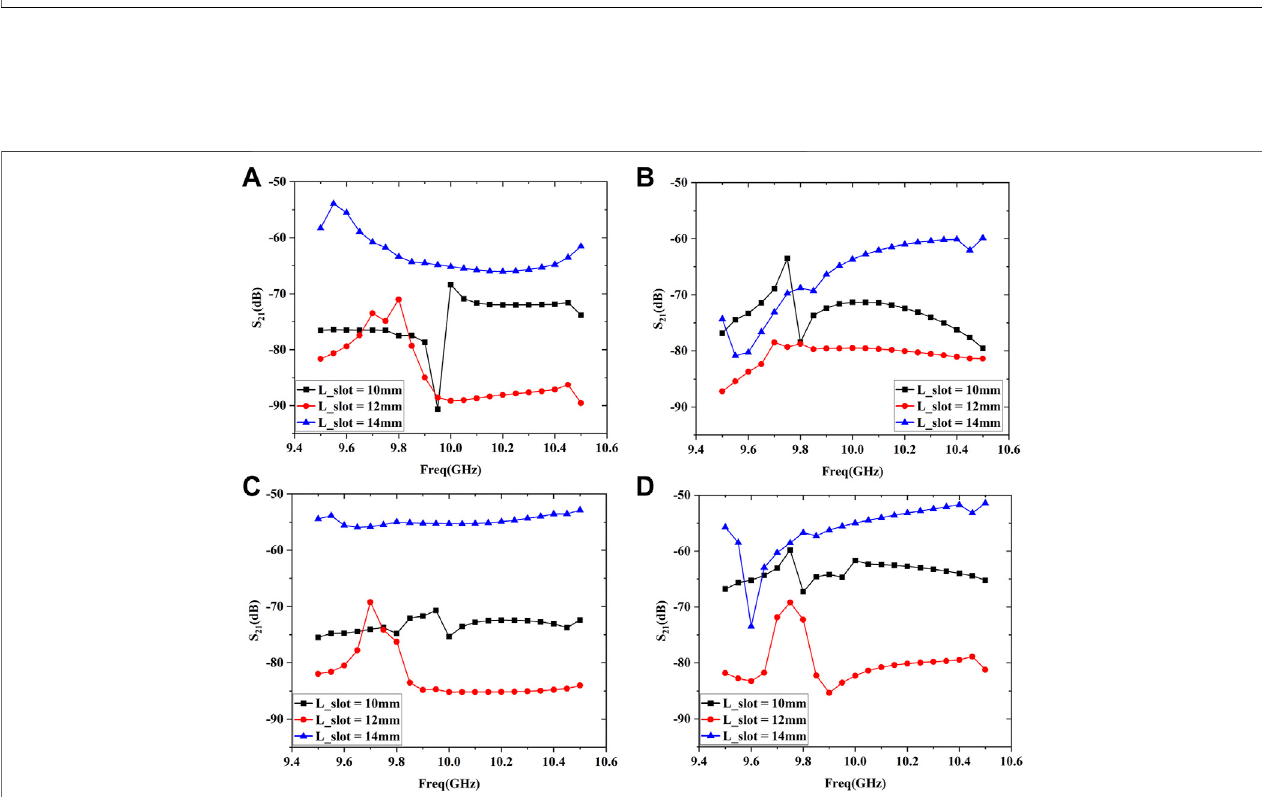
FIGURE 6 | In fl uence of radial slot length on coupled mode transmission. (A) TE 11 mode. (B) TM 11 mode. (C) TE 31 mode. (D) Sum of TE 11 , TM 11 and TE 31 mode.